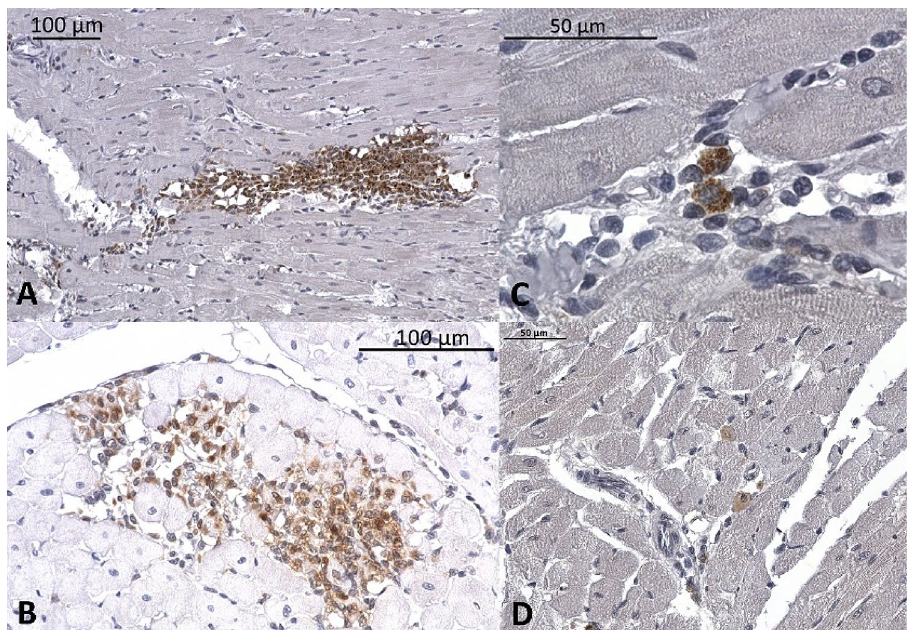
Figure 4. Histological analysis of cardiac macrophage infiltration using CD68 antibody (brown) in sections of O-ZSF1 hearts. Nuclei are stained blue. Exemplary pictures show: ( A ) and ( B ) massive accumulation of macrophages, ( C ) and ( D ) single cells in different